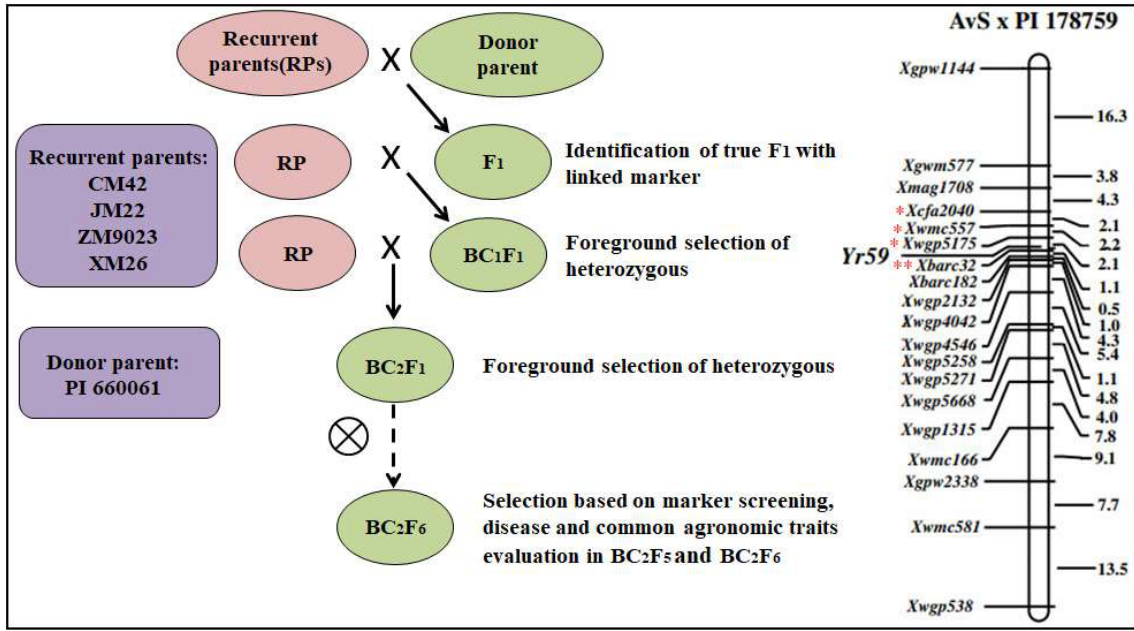
Figure 1. The scheme of introgressing stripe rust resistance gene Yr59 into four elite wheat cultivars through marker-assisted backcrossing (MABC). The Yr59 linkage map was adopted from Zhou et al. (2014). The marker with two asterisks (**) was used in genotyping F 1 , BC 1 F 1 and BC 2 F 1 plants, and the markers with one (*) and two asterisks (**) were used to screen the BC 2 F 5 and BC 2 F 6 lines.